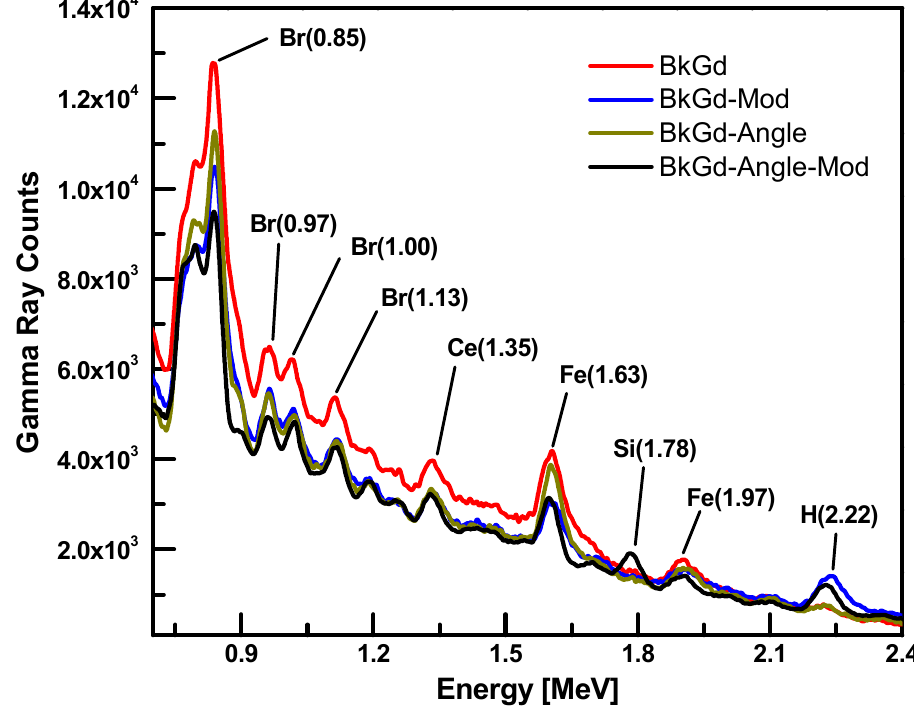
Figure 1. Four prompt gamma-ray spectra were collected from an empty sample container and a CeBr 3 detector. These spectra were related to the direct background (BkGd), background with a moderator before the detector (BkGd-Mod), background with angling the neutron generator tube (BkGd-Angle), and background with angling the neutron generator tube and adding a moderator directly before the detector (BkGd-Angle-Mod).